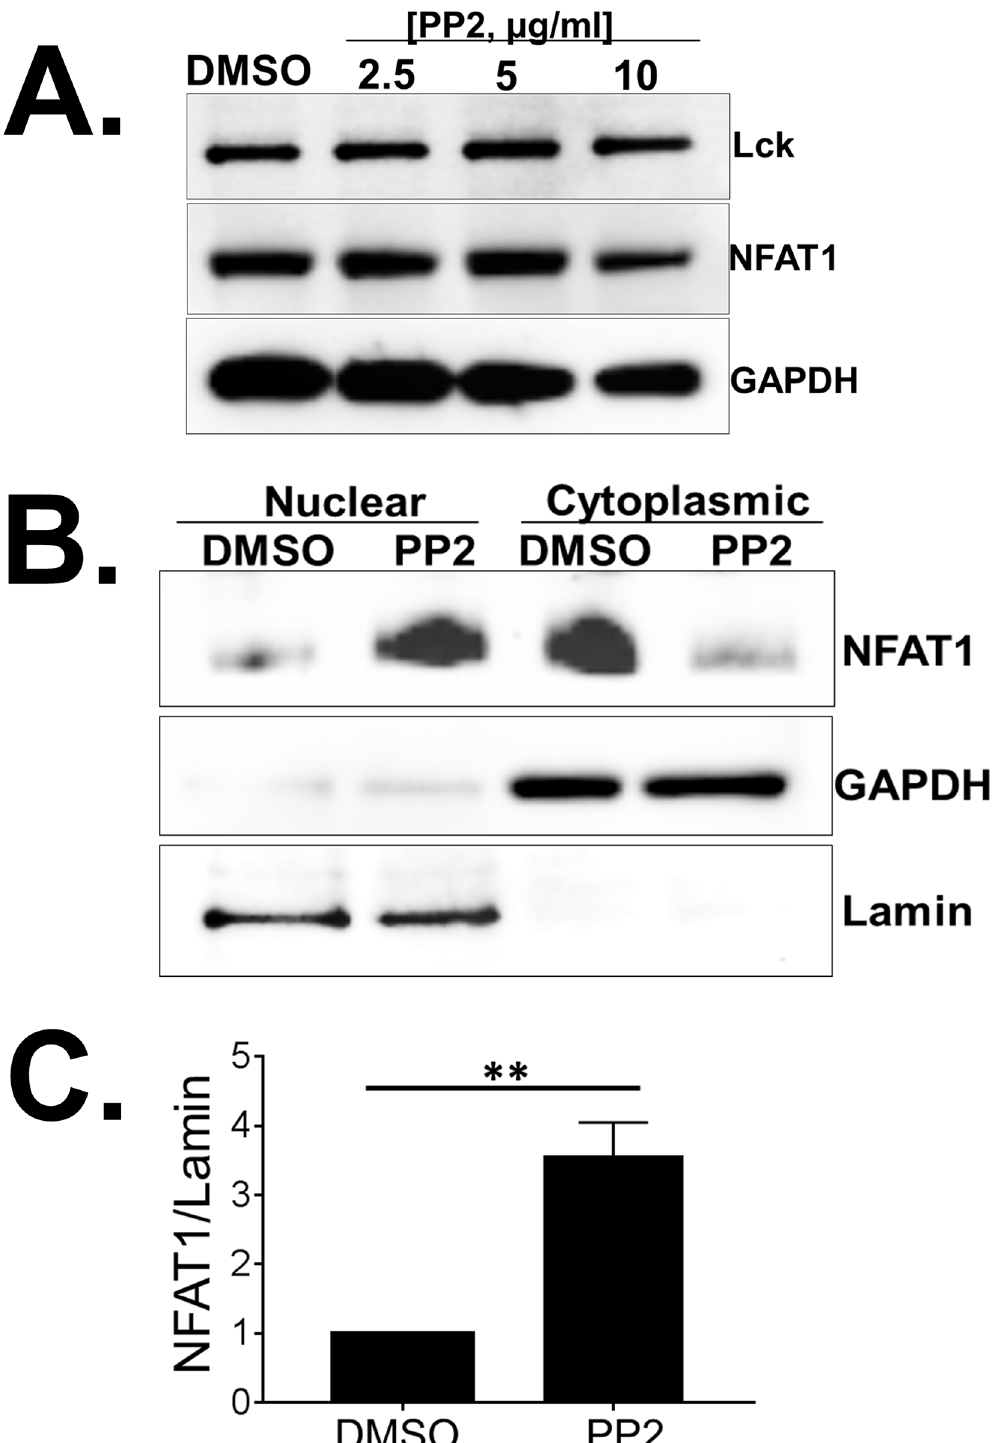
Fig 3. Src-family kinases (SFKs) regulate NFAT1 signaling in unstimulated Jurkat T cells. (A) Immunoblot analysisof Src-kinase Lck and NFAT1 protein expression in Jurkat T cells treated with variousconcentrations of PP2. (B) Immunoblotanalysisof subcellular localization of NFAT1, GAPDH and Lamin in Jurkat T cells treated with DMSO or PP2. GAPDH and Lamin served as a loadingcontrol for cytoplasmic and nuclear fractions respectively. (C) Quantificationof NFAT1 protein in the nuclear fraction of Jurkat T cells either treated with DMSO or PP2.